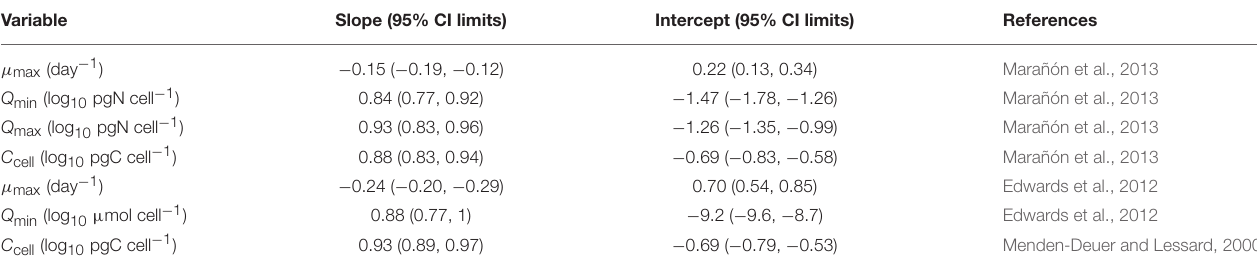
TABLE 1 | Allometric equations used to calculate monoculture productivities and standing stocks.